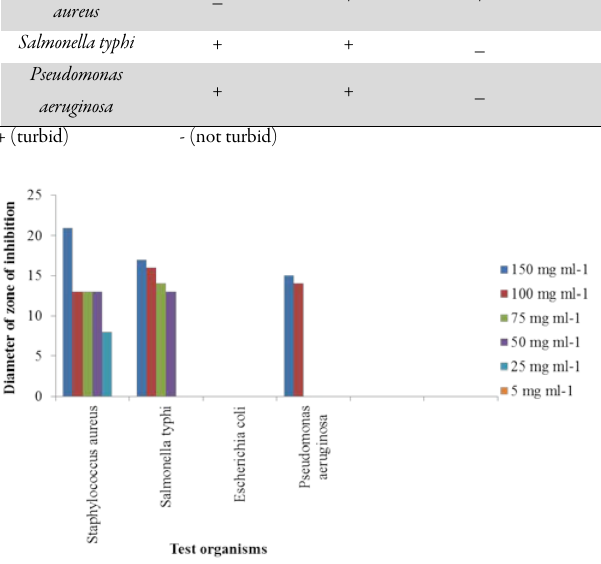
Fig. 3. The effect of varying concentrations of methanolic extract on the test organisms